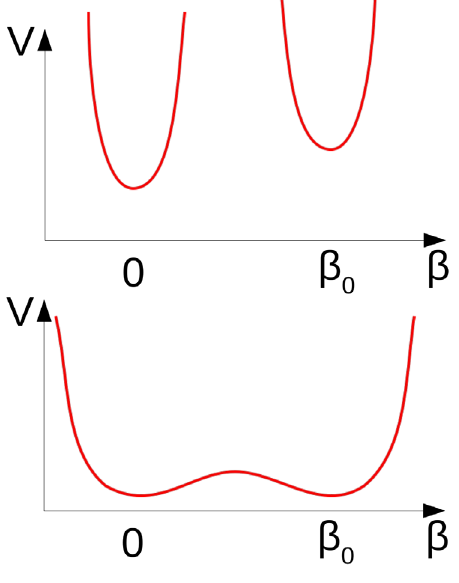
Figure 1. Schematics of nuclear potentials with local minima at β = 0 and β = β 0 , (top) in case of a high potential barrier and (bottom) in case of a low potential